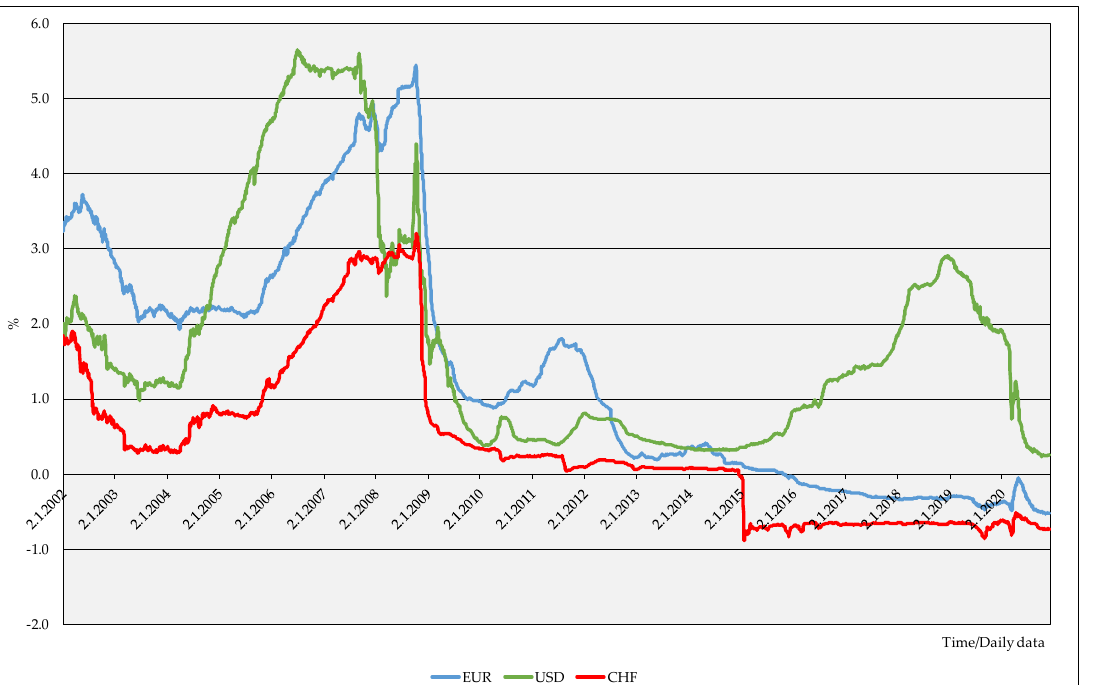
Figure 5. Six-month ZIBOR, monthly average for the September 2002–December 2019 period. Source: Author’s presentation of the CNB data, official website, based on excel table e-g7b-Interest rates quoted on the interbank market (ZIBOR). Table 5. Descriptive statistics of 6-month LIBOR major currencies, 2 January 2002–2 December 2020 ( N = 4784). 6-Month LIBOR (Daily Data)